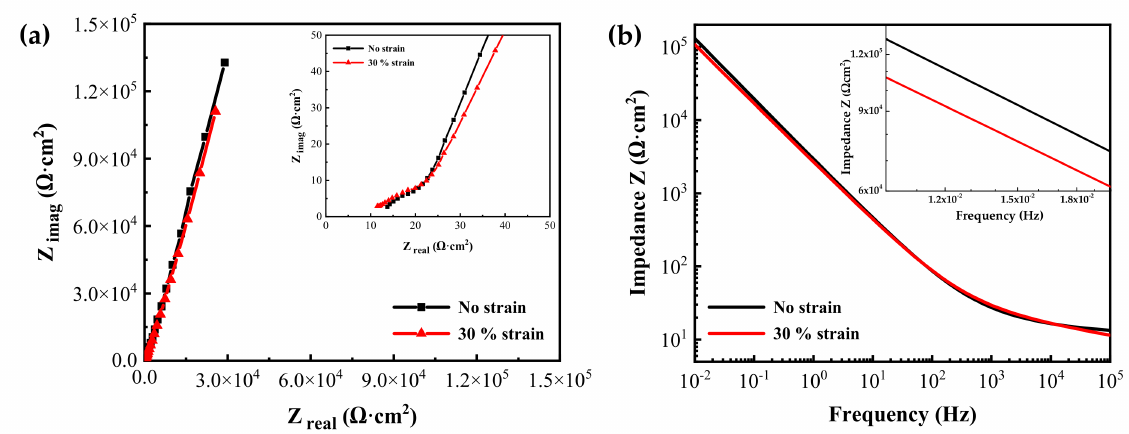
Figure 8. ( a ) Nyquist and ( b ) Bode plots of oxide films grown on Alloy 600 specimens with and without 30% tensile strain in simulated PWR secondary water at 340 ◦